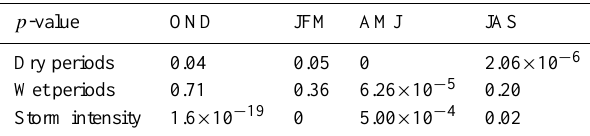
Table 2. P -value results of the Wilconox rank sum test for the difference of means between observed and RCM data (reference period 1961–1990) at a 95% confidence level.